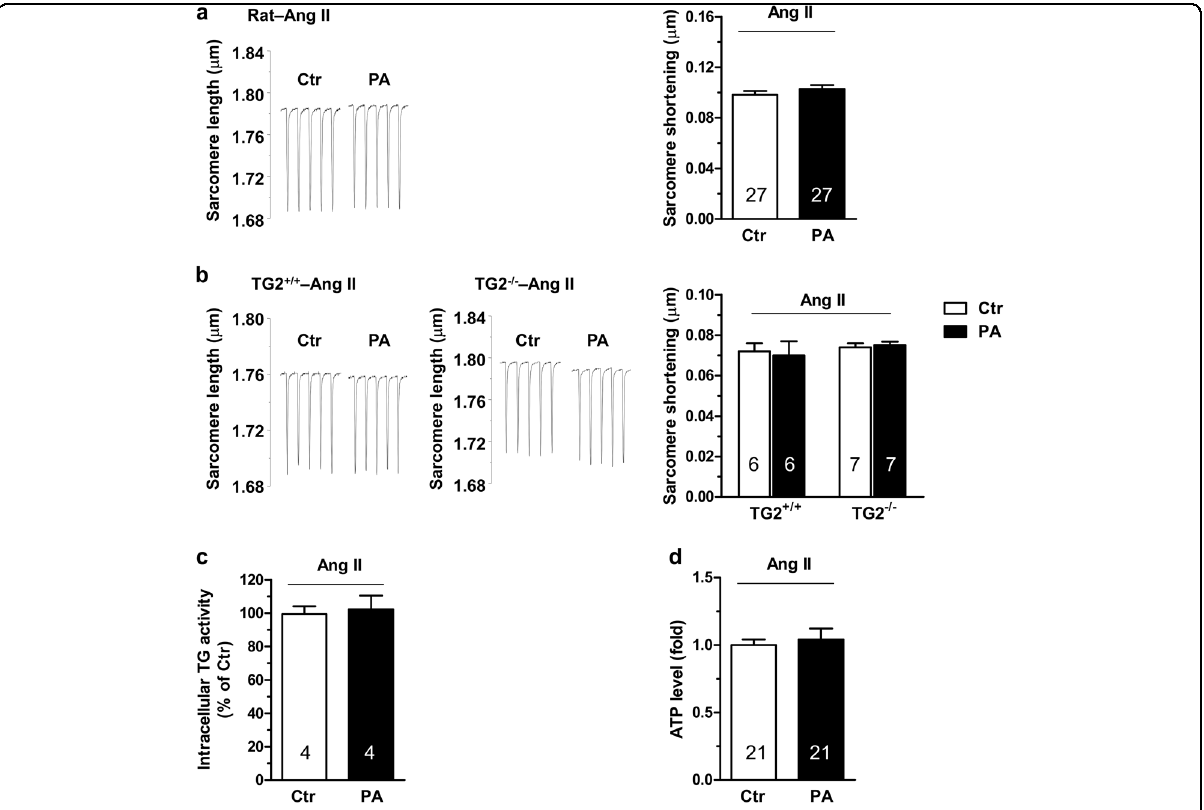
Fig. 3 Palmitic acid-dependent contraction is impaired in cardiomyocytes from Ang II-treated rats and mice. a , b A representative graph showing sarcomere length in LV myocytes from Ang II-treated rats ( a ) and wild-type and TG2-de fi cient mice ( b ). The difference between diastolic and systolic sarcomere length ( Δ sarcomere shortening) was compared (right). c , d Effects of PA supplementation on intracellular TG2 activity levels ( c ) and ATP levels ( d ) in LV myocytes from Ang II-treated rats. Data represent mean ±